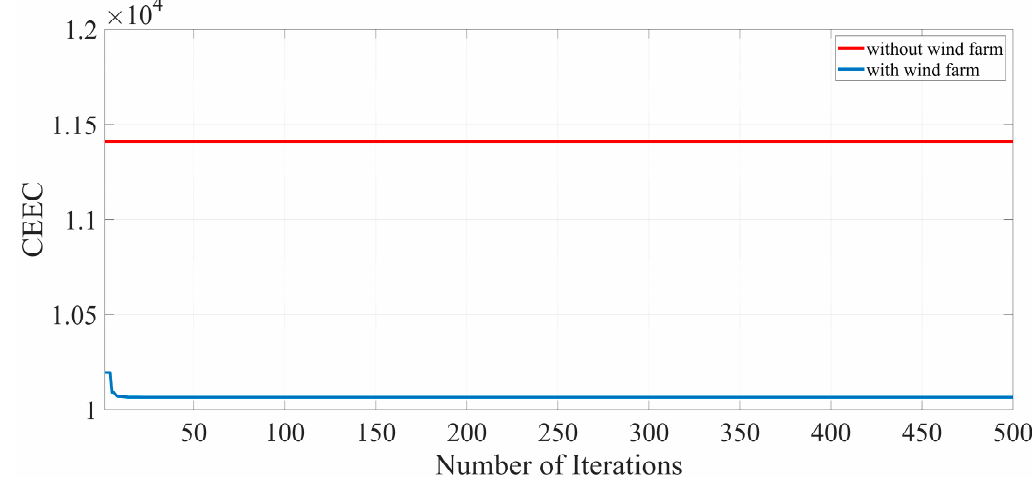
Figure 10. The convergence curves for emission minimization for the Test System 2.